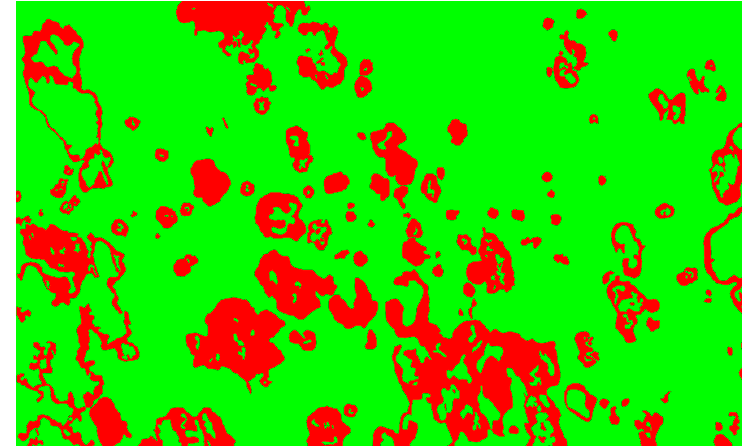
Figure 11. The ground-truth map of Chase field was used for accuracy assessment (Scale